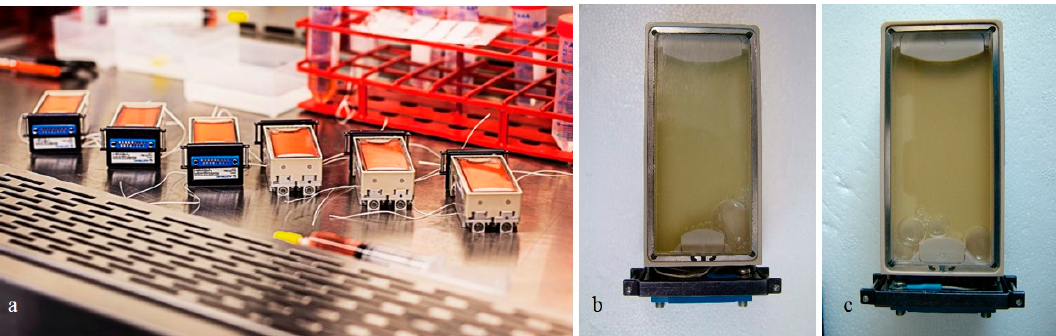
Figure 1. ( a ) Cell suspensions prepared in six spaceflight experiment containers. They were flown to the ISS, and another set was kept on ground as 1 g -controls; ( b , c ) The cell culture chambers of the experiment units containing cell monolayers fixed with RNA later.